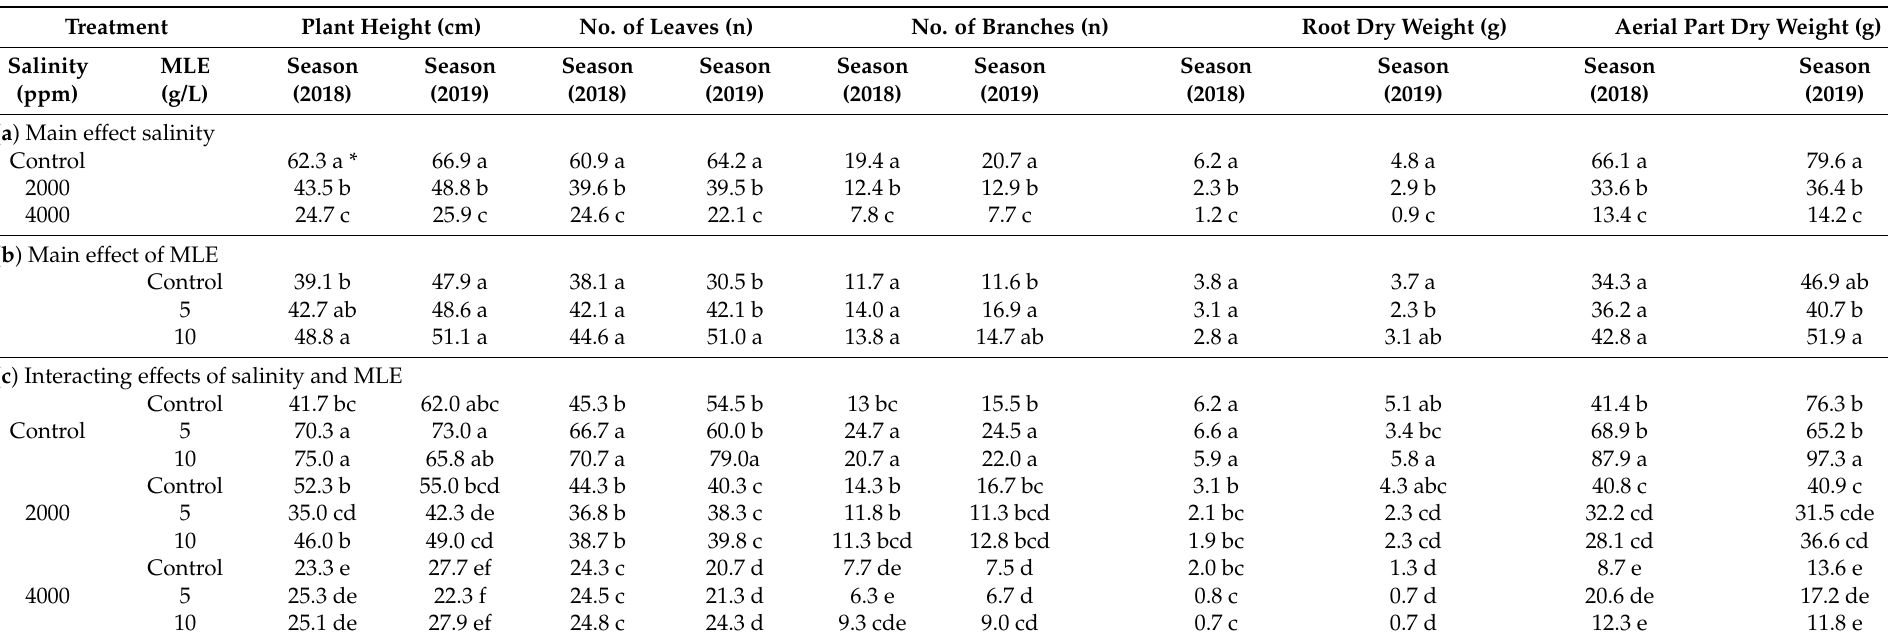
Table 4. Effects of salinity levels; Moringa oleifera leaf extract (MLE) concentrations; and their interactions on plant height (cm), number of leaves (n), number of branches (n), root dry weight (g), and aerial part dry weight of S. marianum plants during the 2018 and 2019 planting